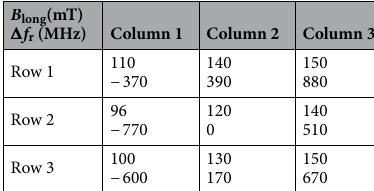
q 3 q 2 q 1 q 0 (cid:30) = | 1101 � (cid:31)